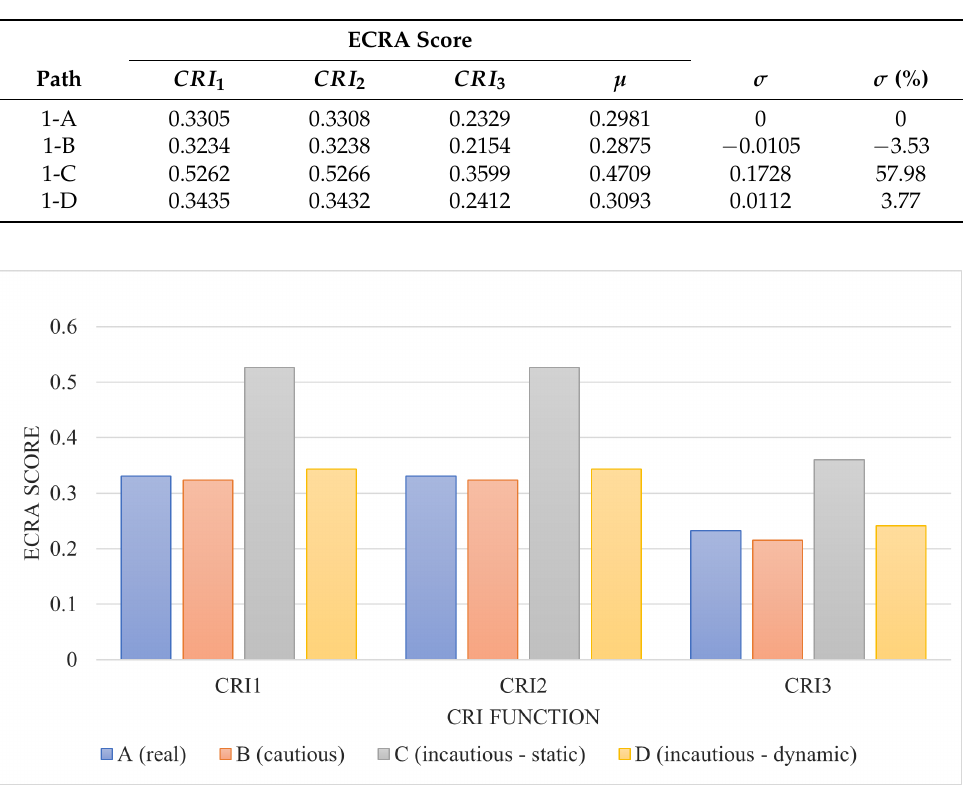
Figure 13. A plot showing resulting ECRA scores for four scenarios of test case 1, using three different CRI